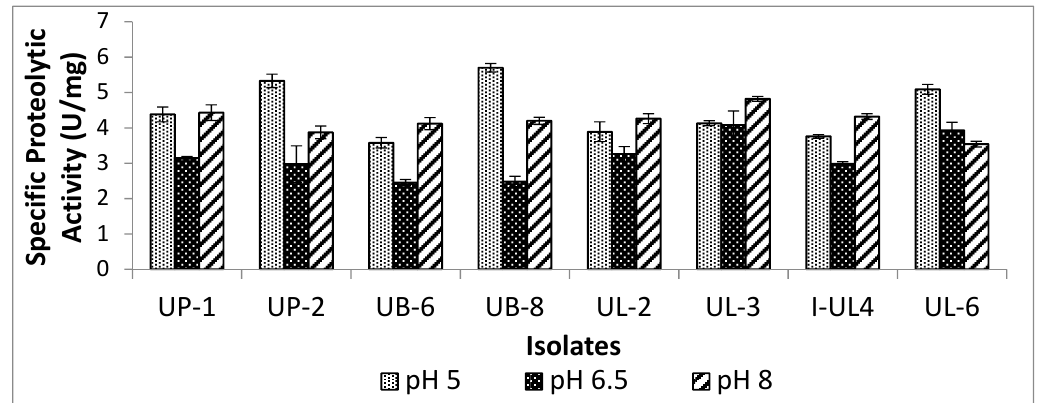
Figure 1. The extracellular proteolytic activity of lactic acid bacteria (LAB) under three different pH conditions.